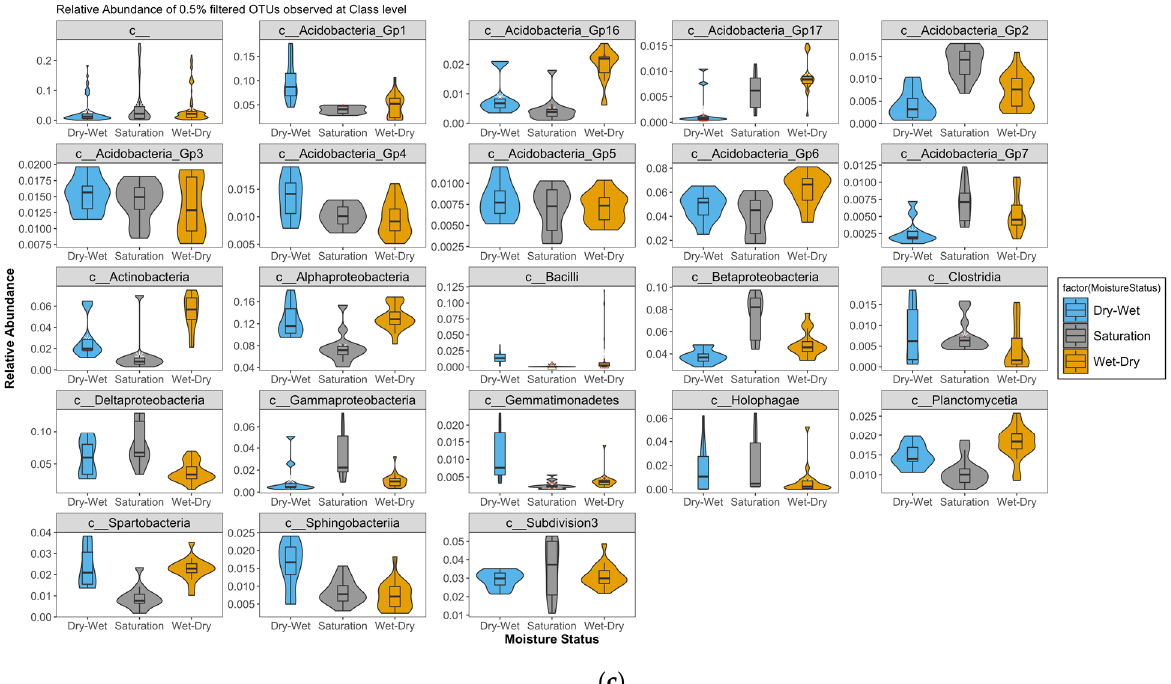
Figure 1. ( a ) Ordination plots showing separation of all OTUs by moisture treatments visualized by nonmetric multidimensional scaling (NMDS) of Bray–Curtis distance metrics. The three moisture treatments are shown in blue (Dry-Wet), grey (Saturation), and orange (Wet-Dry). The biological replicates and their technical replicates are shown by distinct symbols for each moisture treatment and listed under BioRep for their unique experimental IDs. ( b ) Relative abundance (>0.5%) of OTUs at the phylum level measured for each moisture treatment (Dry-Wet, Wet-Dry, and Saturation). Data are shown as violin plots where whiskers indicate the most extreme values within 1.5 multiplied by the interquartile region. Box, 25% quartile; median, 75% quartile. Pairwise comparisons of means to test treatment effects were performed after outlier removal. ( c ) Relative abundance (>0.5%) of OTUs at the class level measured for each moisture treatment (Wet-Dry, Dry-Wet, and Saturation). Data are shown as violin plots where whiskers indicate the most extreme values within 1.5 multiplied by the interquartile region. Box, 25% quartile; median, 75% quartile. Pairwise comparisons of means to test treatment effects were performed after outlier removal.